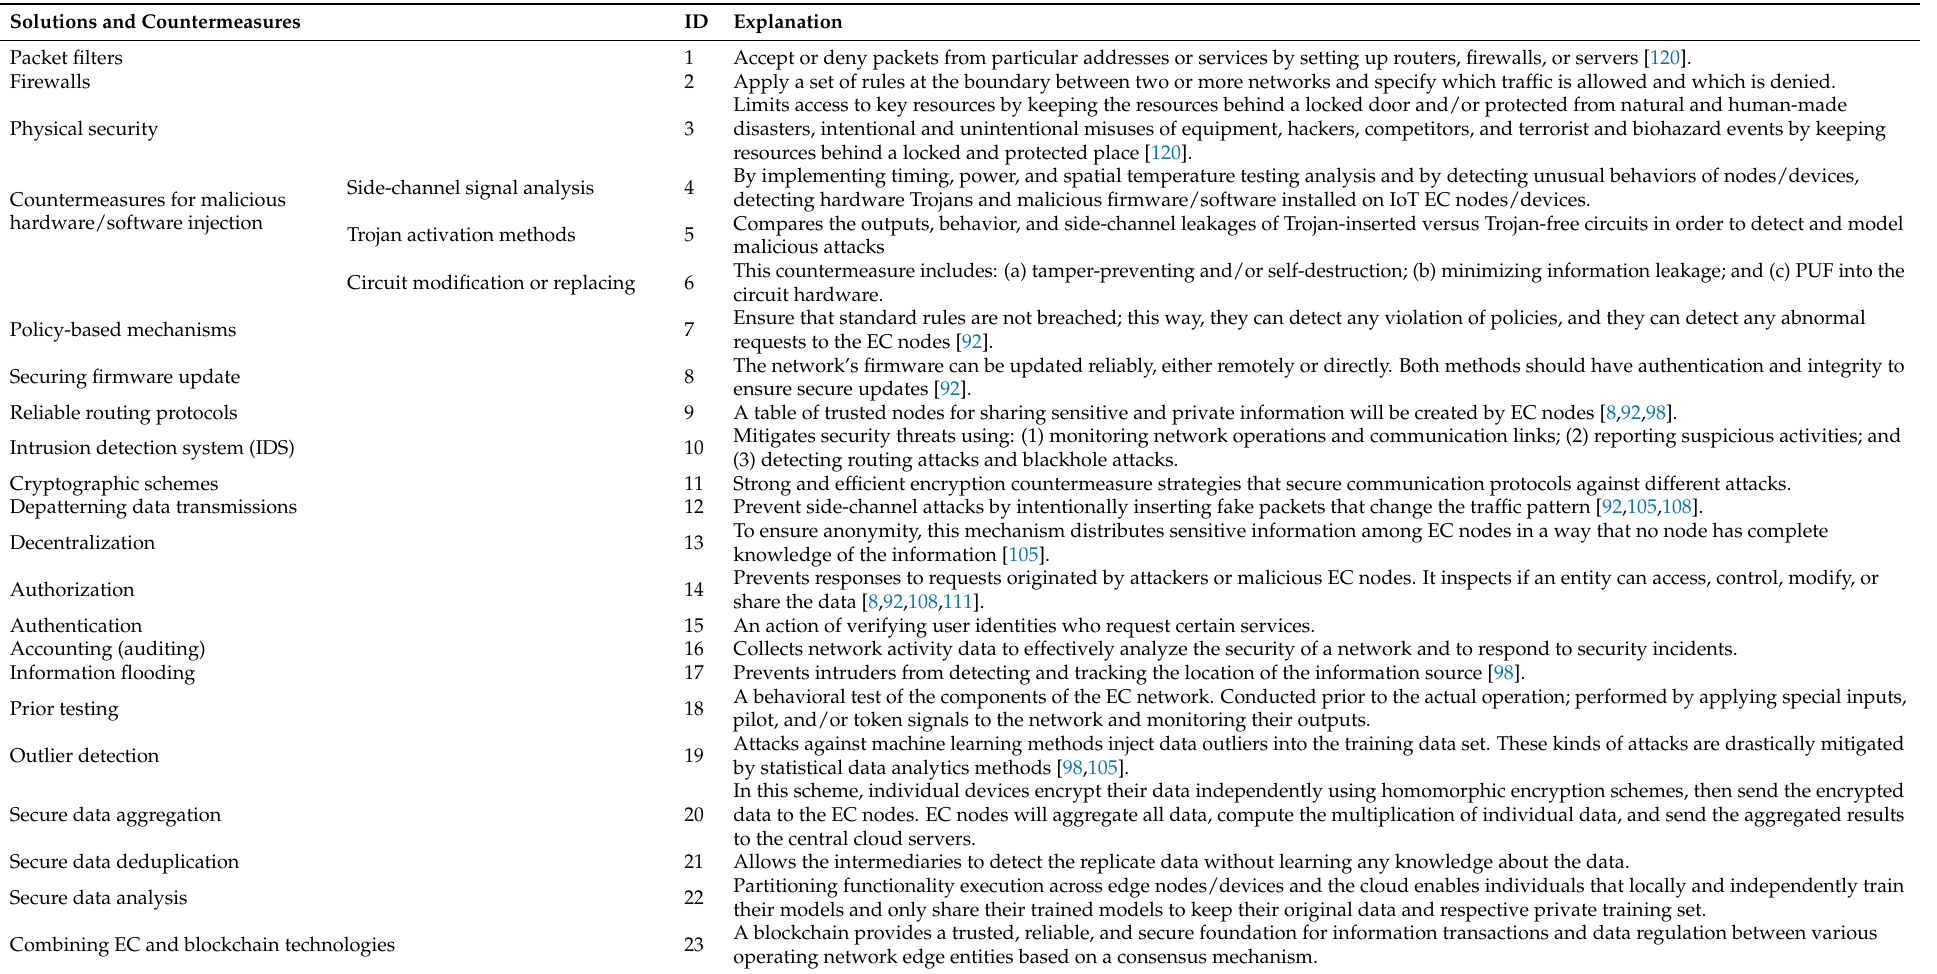
Table 2. Summary of security and privacy solutions and